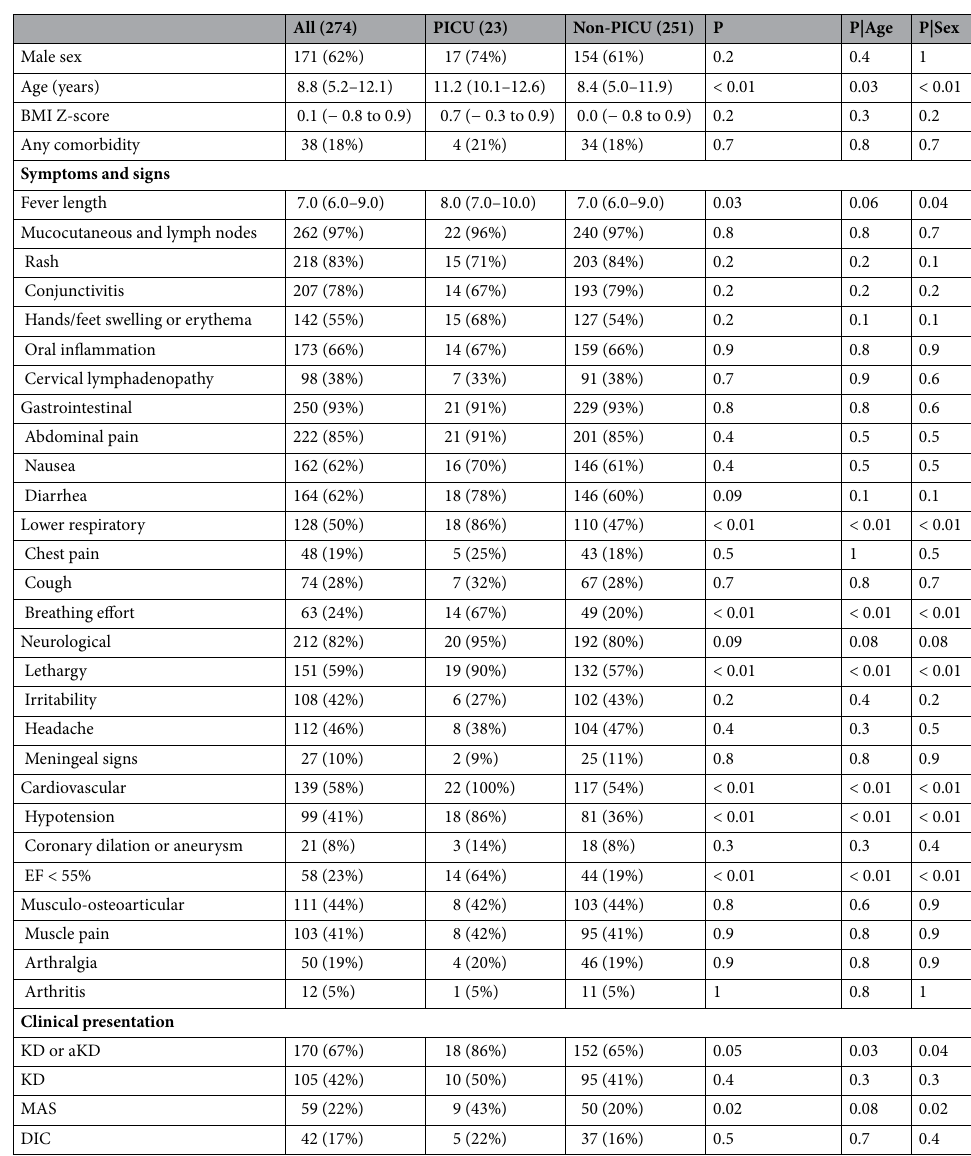
Table 4. Demographic and clinical characteristics of MIS-C cohort respective of pediatric intensive care involvement. Binary data given as count (per-cent), and numerical data as median (interquartile